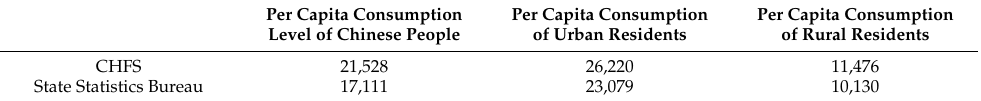
Table 1. Per capita consumption data from China’s National Bureau of Statistics and CHFS. Per Capita Consumption Level of Chinese People